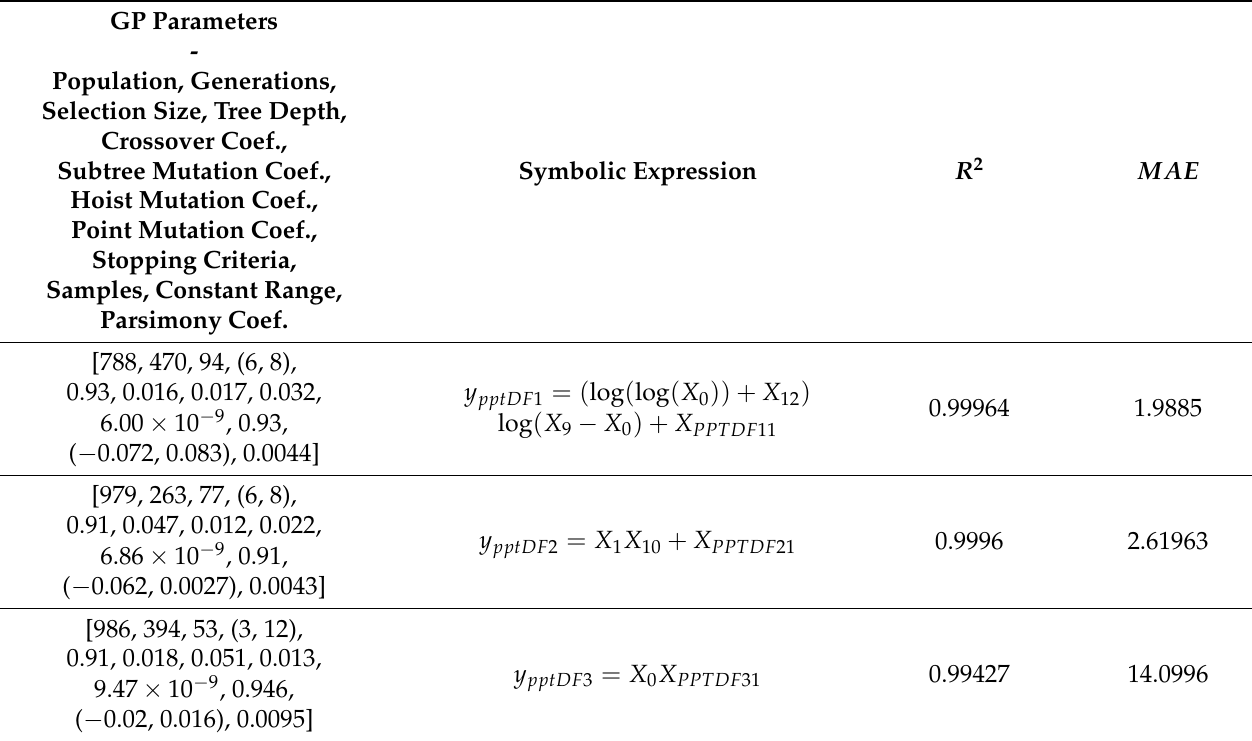
Table 10. Three best symbolic expressions for port propeller torque estimation with decay state coefficients with correspond- ing R 2 and MAE score. GP Parameters - Population, Generations, Selection Size, Tree Depth, Crossover